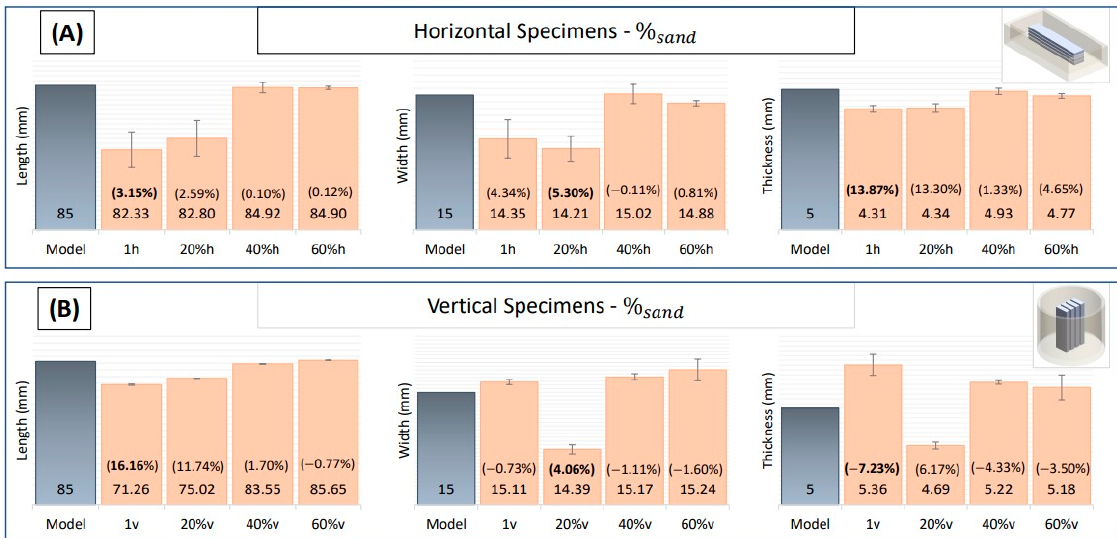
Figure 7. Average geometric distortion (shrinkage) of specimens under variable sintering hold time ( Δ (cid:3035)(cid:3042)(cid:3039)(cid:3031) ). ( A ) Horizontally built specimens. ( B ) Vertically built specimens. Absolute values of each measure are in mm, and relative variation from CAD model is a percentage. Negative values indi- cate an increase in size.